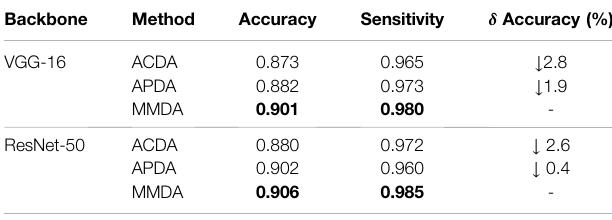
TABLE 3 | The DR classi fi cation results of MMDA with different backbones on the APTOS 2019 dataset. Backbone